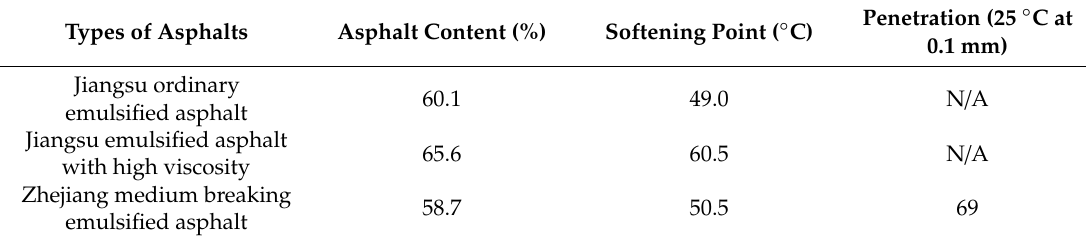
Table 4. Basic properties of di ff erent emulsified asphalts.